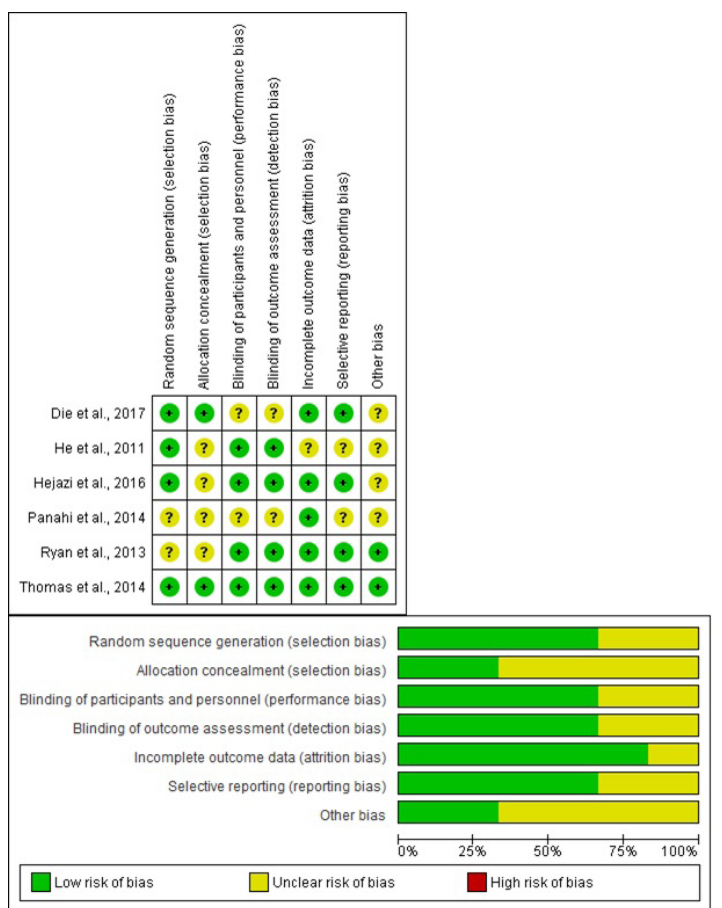
FIGURE 3 – Assessment of bias risk. (a) Bias risk summary: a review of each bias risk item for each included study. (b) Bias risk chart: a review of each bias risk item, expressed in %, for all included